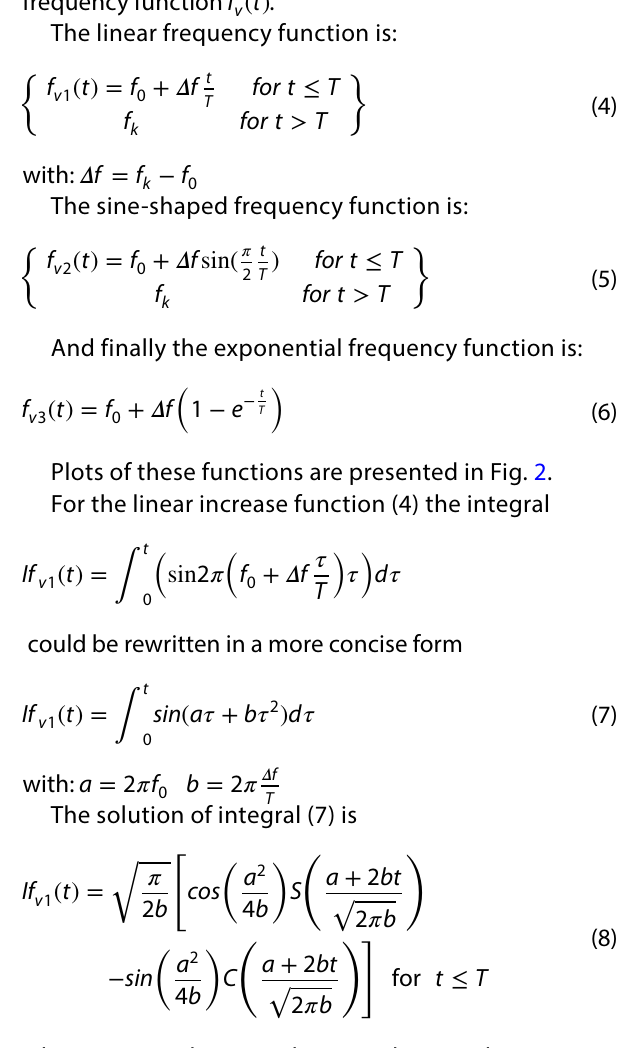
Fig. 2 Voltage frequency functions: linear f v 1 , sinusoidal f v 2 and exponential f